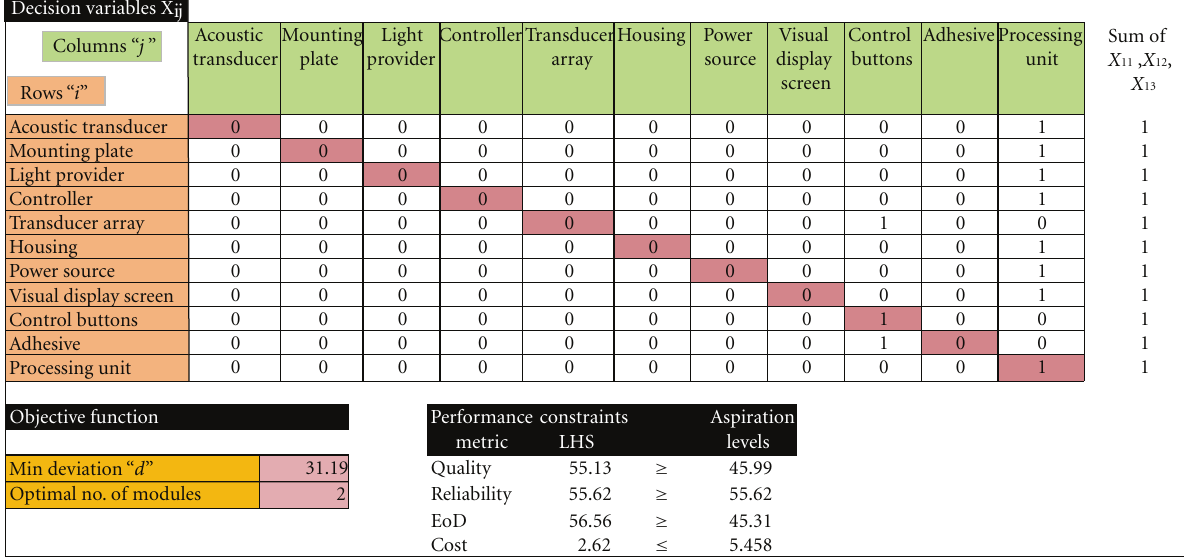
Figure 8: Final GP—optimal number of modules N ∗ —stakeholder 1